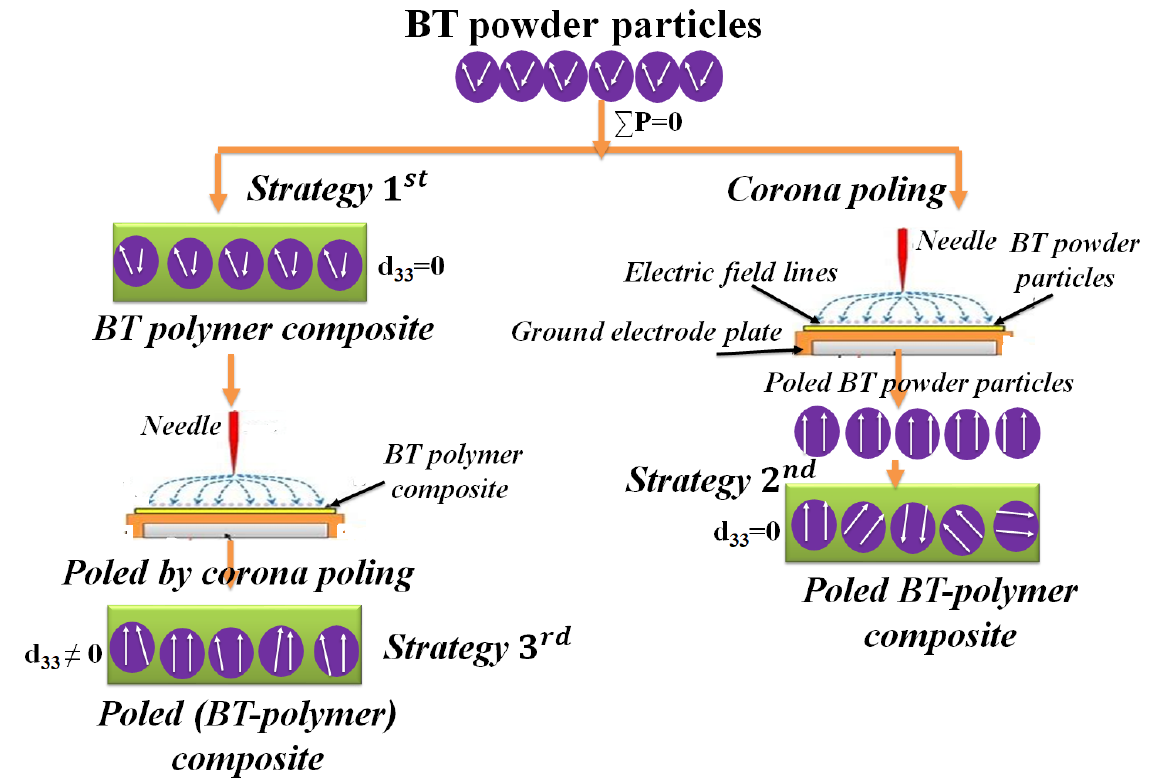
Figure 2. Typical fabrication steps for BaTiO 3 composite samples.